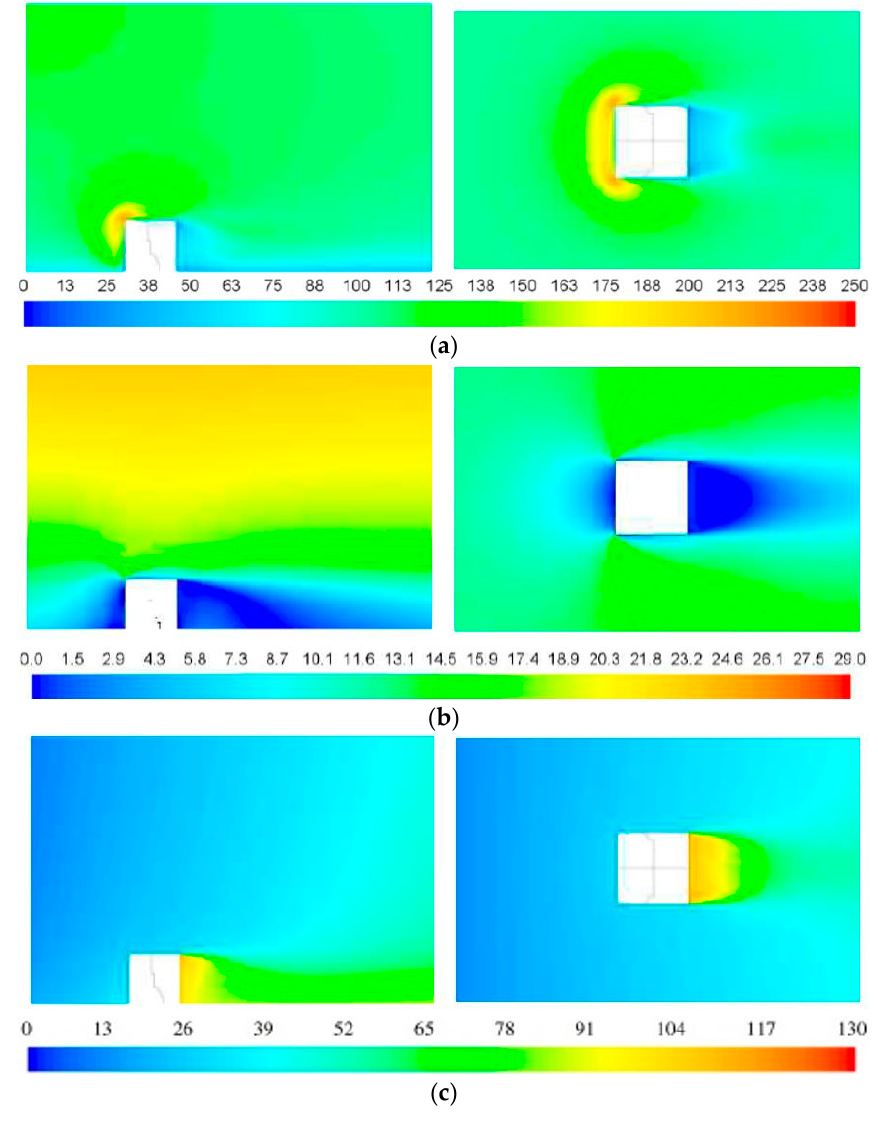
Figure 10. Air behaviour in the built environment (y = 0, z = 4 H /5). ( a ) Turbulent intensity (%); ( b ) dynamic pressure (pascal); ( c ) residence time (s).